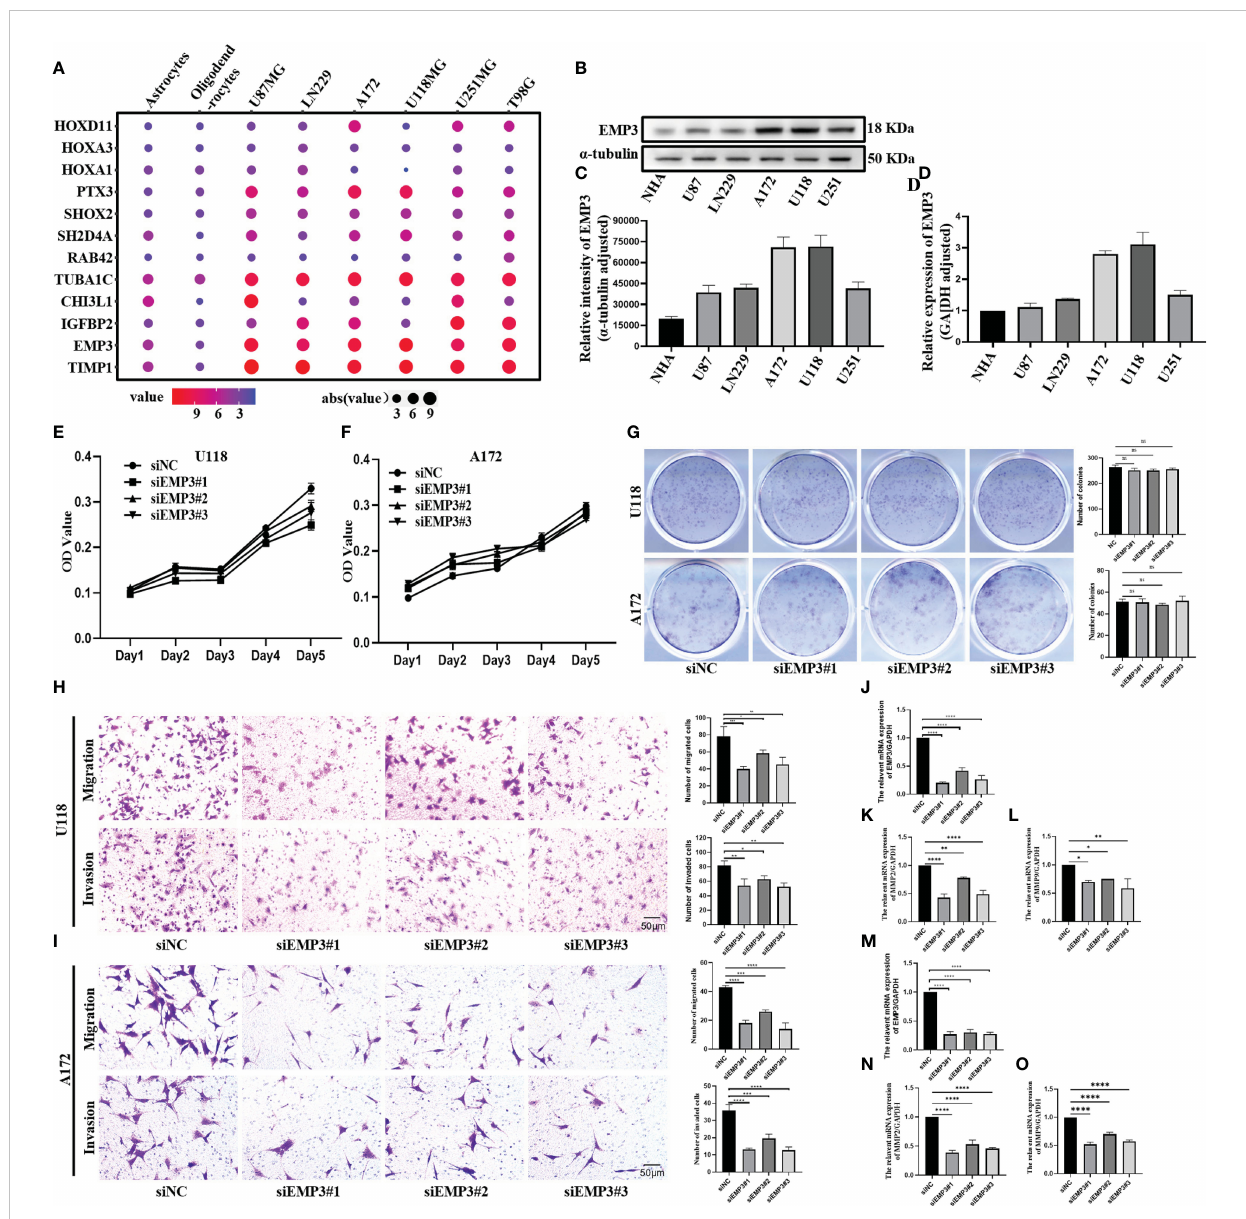
FIGURE 9 EMP3 silencing attenuates the migration and invasion of glioma cells. (A) The expression of EMP3 in different cell lines in the CCLE datasets. (B – D) Western blot and qPCR display EMP3 express highly in U118 and A172. (E – G) The growth curve and plate cloning experiment display that EMP3 silencing has little effect on the cell proliferation of U118 and A172. (H, I) EMP3 knockdown inhibits the migration and invasion of glioma cells. ( J – O , 20×) qPCR displays EMP3 silencing attenuates the expression of MMP2 and MMP9 expression (ns, p > 0.05; * p < 0.05; ** p < 0.01; *** p < 0.001; **** p <